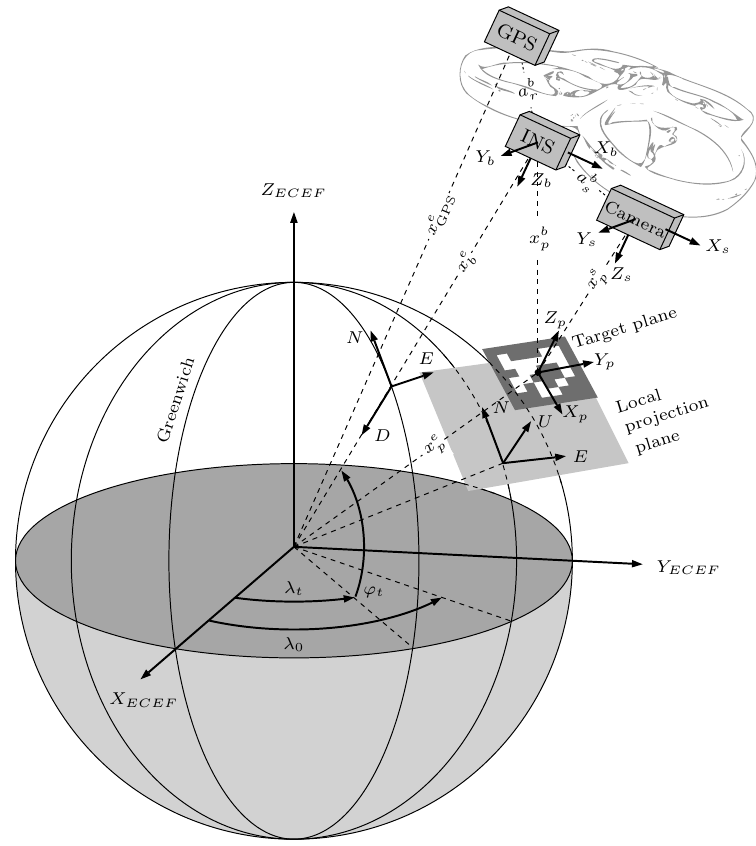
Figure 1: MAV-based direct